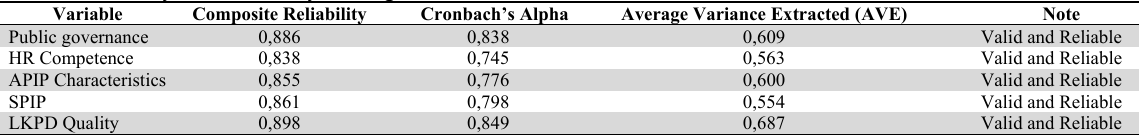
Results of Validity and Reliability Testing Variable Composite Reliability